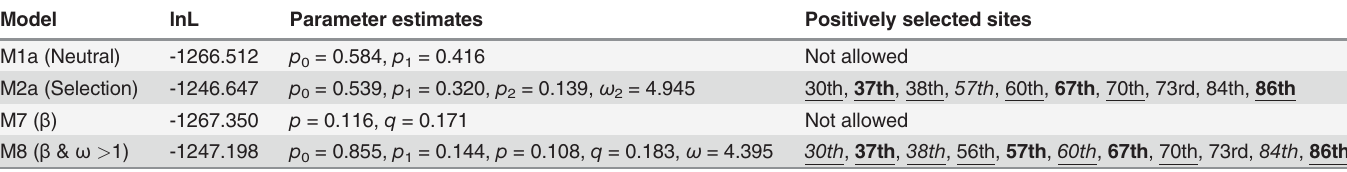
Table 2. Positively selected sites of Hume ’ s pheasant MHCIIB exon 2 sequences from implementing neutral (M1a, M7) and selection (M2a, M8) models in CODEML [26].